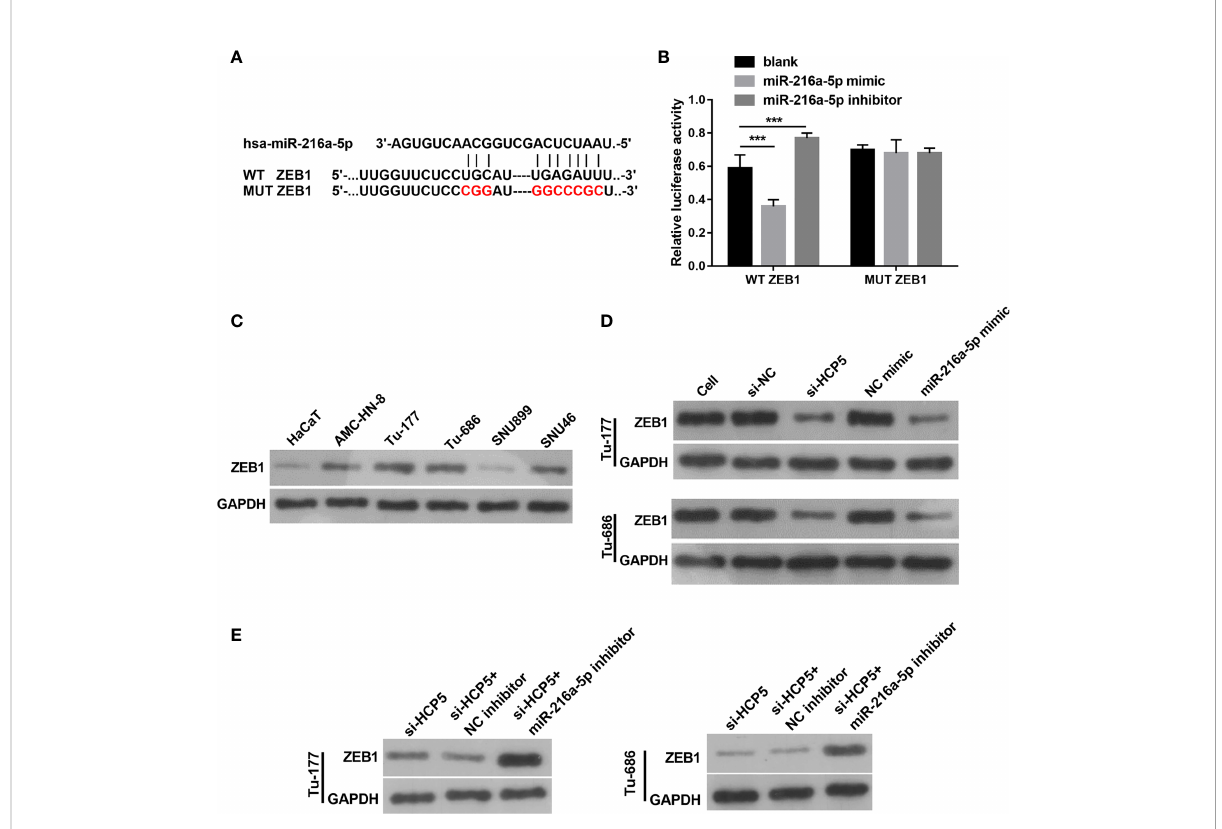
FIGURE 6 ZEB1 is a directly regulated target gene of miR-216a-5p. (A) The direct binding sites between ZEB1 3 ′ -UTR and miR-216a-5p were predicted by bioinformatic analysis. The mutant binding site of ZEB1 was also exhibited. (B) A dual-luciferase reporter assay certi fi ed that miR-216a-5p directly binds to ZEB1. (C) Protein levels of ZEB1 in LSCC cell lines was measured by Western blot, respectively. (D) The effect of silenced HCP5 or overexpression of miR-216a-5p on the protein expression of ZEB1 in Tu-177and Tu-686 cells was measured by Western blot. (E) The effect of cotransfected si-HCP5 and miR-216a-5p inhibitor on ZEB1 protein in LSCC cells was quanti fi ed by Western blot. n =3, ***p